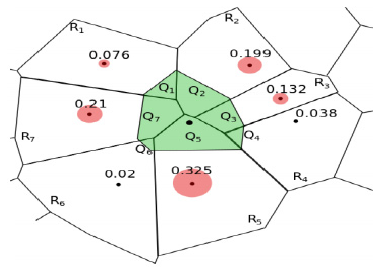
Figure 8. The natural neighbor interpolation method. The area of the colored circles are the interpolating weights. The shaded area is a new Voronoi element for the point to be interpolated [48].